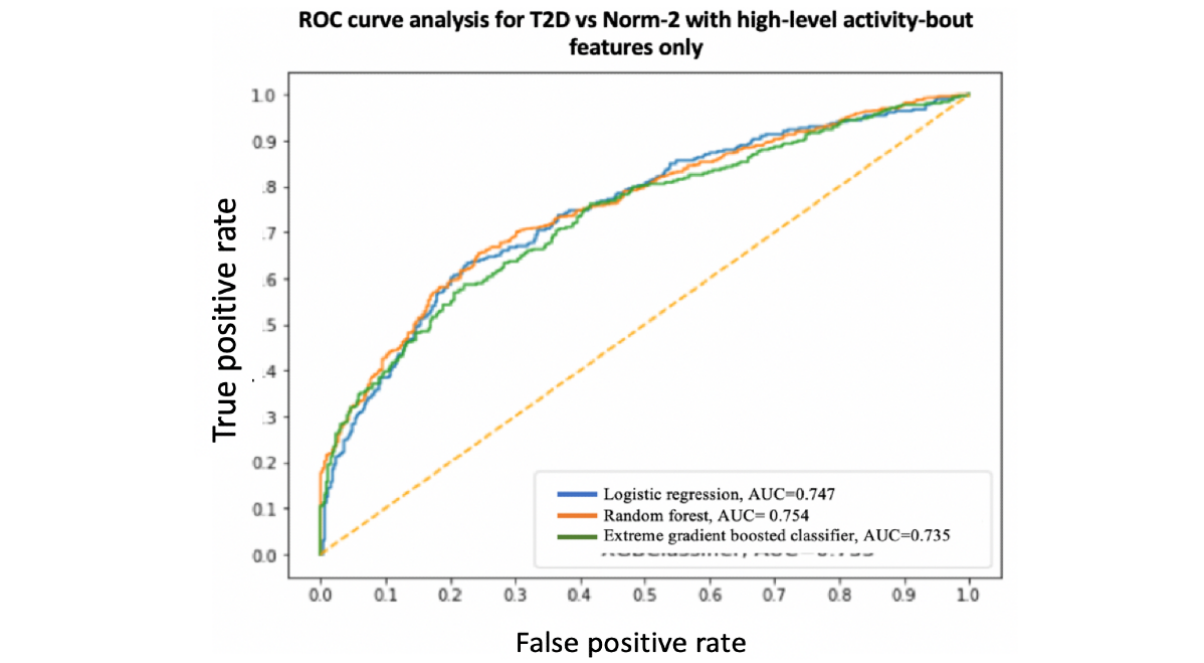
Figure 11. Receiver operating characteristic curve and area under the receiver operating characteristic curve for type 2 diabetes vs Norm-2: High-level activity bout features only. AUC: area under the receiver operating characteristic curve; ROC: receiver operating characteristic curve; T2D: type 2 diabetes.